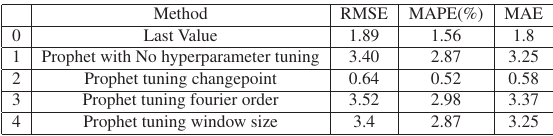
Table 2. Performance Evaluation